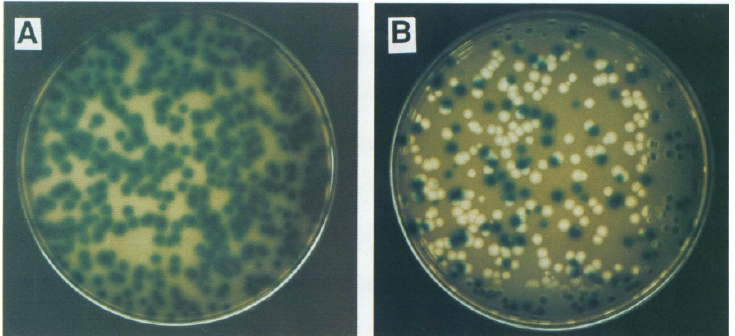
Figure 3. Effect of the hairpin secondary structure in noncoding region of M segment on the stability and homogeneity of the virus. Photograph of plaques from bacteriophage isolates where lacH is inserted in the noncoding region of the M segment and bordered with poly-G and poly-C homopolymer arms ( B ) or lacking one of the arms ( A ). Plaques lacking the one of the homopolymer arms are stable and form uniform blue plaques on LB X-Gal substrate ( A ). The lacH gene bordered by homopolymer arms is unstable, producing the white and blue mixed plaque population ( B ). Reproduced from Onodera et al. (1993).